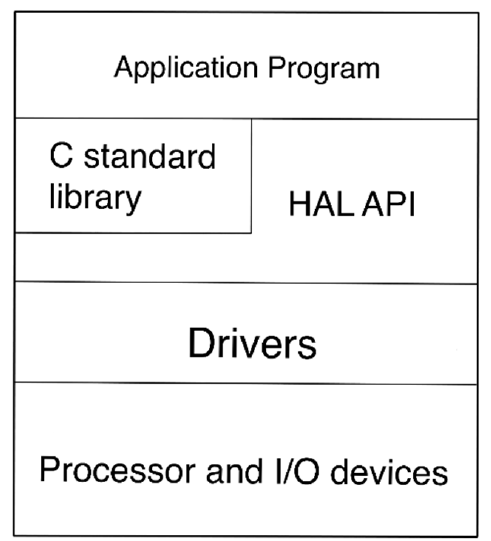
Figure 6. The structure of the HAL software hierarchy.